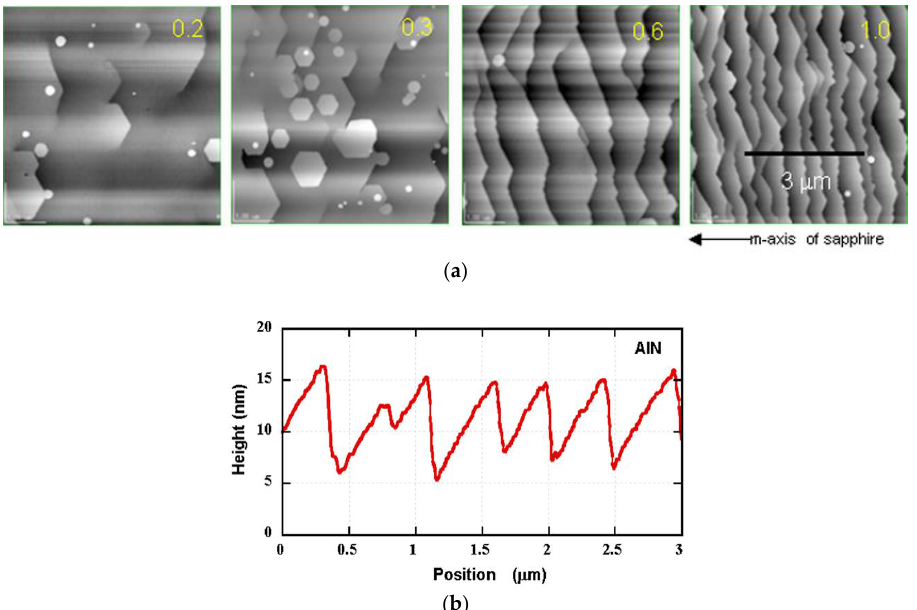
Figure 5. ( a ) AFM images (6 × 6 µm 2 ) of AlN templates on sapphire substrates with various miscut angles after optimizing the AlN growth recipe before starting mass-production. Macrosteps unexpectedly appeared for the low-miscut sapphire samples. The LEDs on these AlN templates showed no adverse effects due to the macrosteps in the reliability tests, indicating the robustness of the QWs grown on macrosteps. ( b ) Height profile of AlN on 1.0°-miscut sapphire along the line in the image. Ra value of AlN template is 2.26. (( a ) images for the miscut angle of 0.3° and 1.0° and ( b ) are permitted to be reused from Jpn. J. Appl. Phys. [13]. © Japan Society Applied Physics).